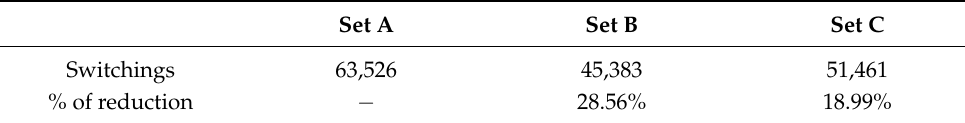
Table 7. The switching number for 2 s of full modulation, 50 Hz.